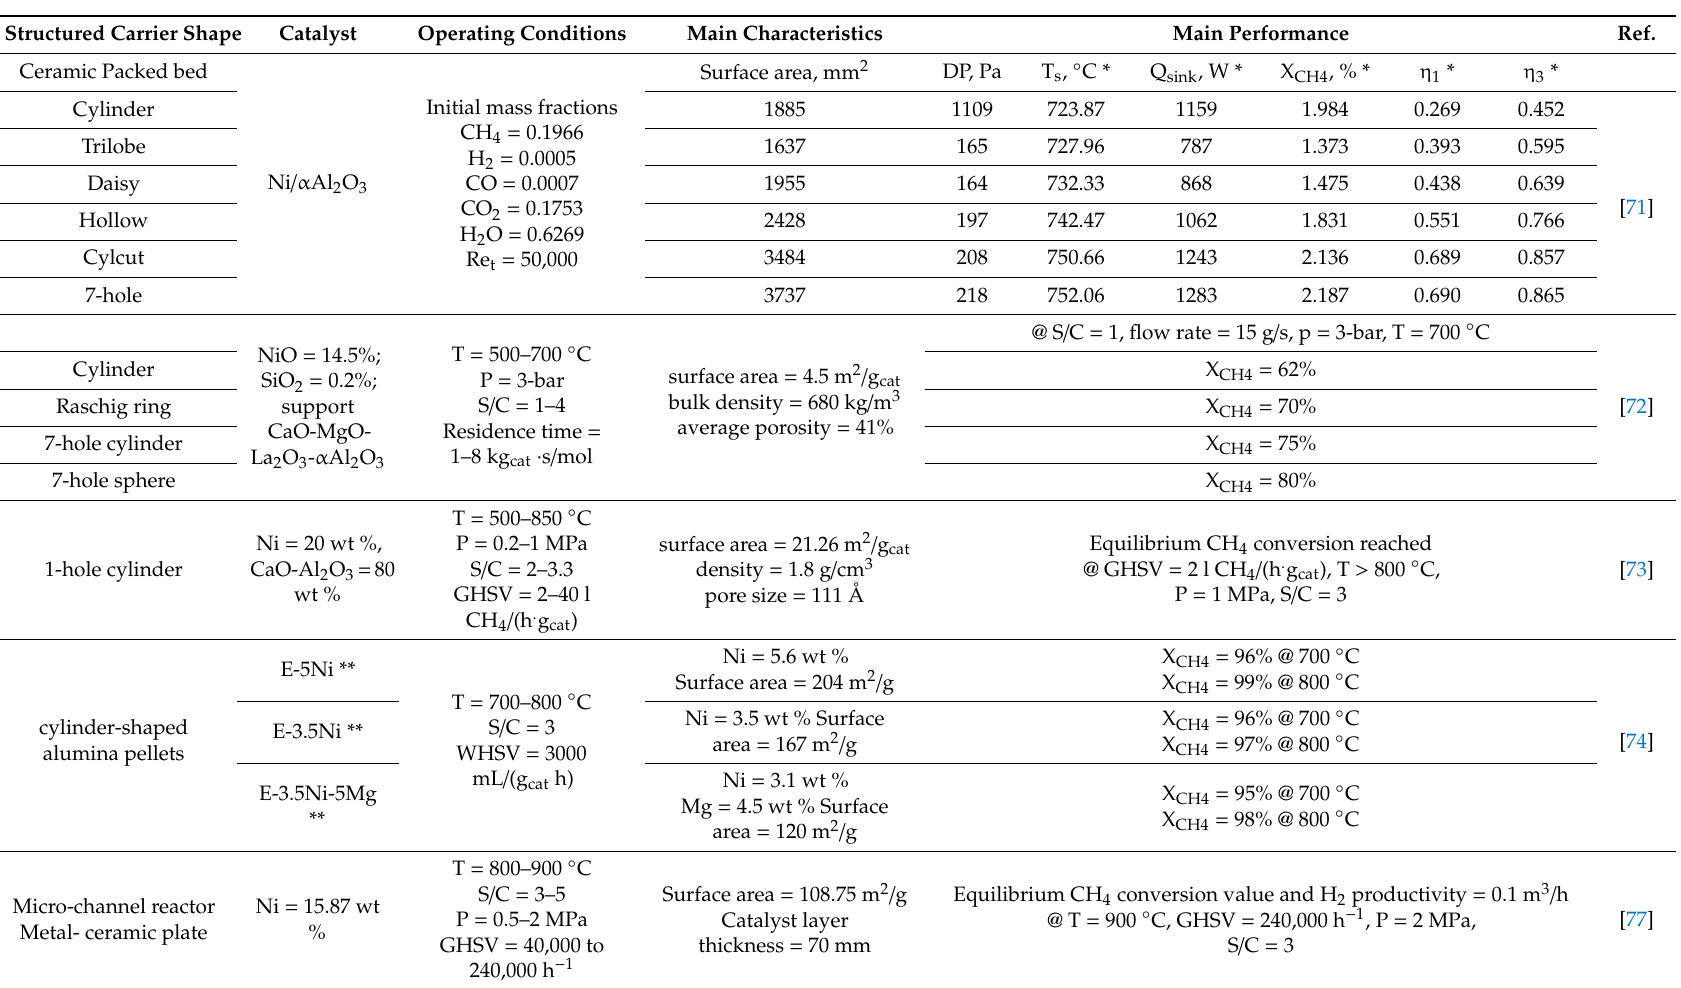
Table 3. Summary of the main performance of the packed bed reactors and of the catalysts supported on metallic carries, compared with a micro-channel catalytic